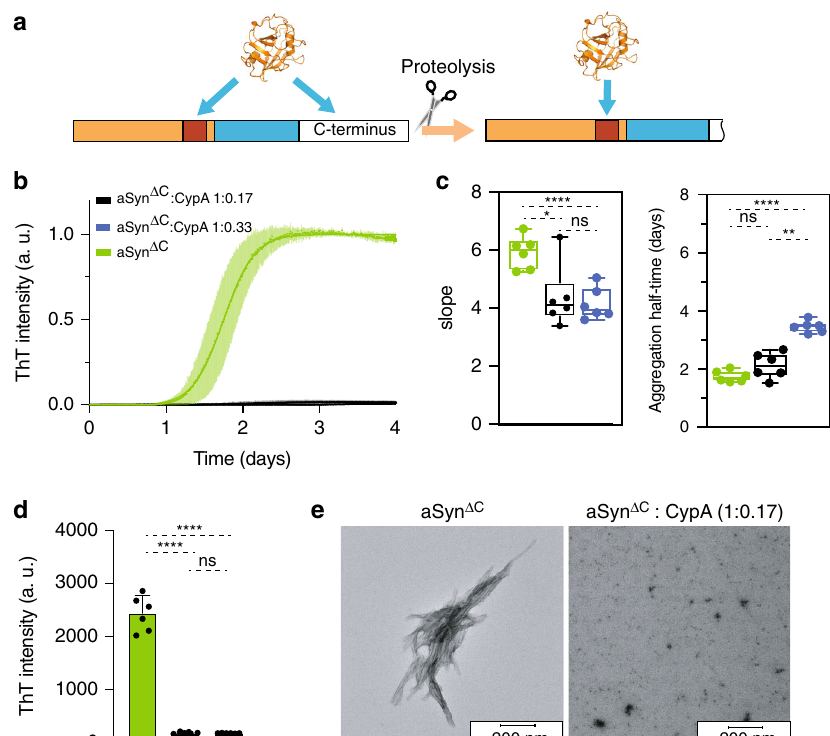
Fig. 5 CypA blocks misfolding of C-terminally truncated aSyn. a Schematic representation of post-translational truncation of the C-terminal domain of aSyn. Truncation leads to a partial or full loss of the proline-rich region and exclusive binding of CypA to aSyn ’ s PreNAC. b ThT- fi brillization assay of C- terminally truncated aSyn alone (aSyn Δ C , 15 μ M, green) and in the presence of substoichiometric concentrations of CypA. Error bars represent the standard deviation of n = 6 independent experiments. An independent experiment leading to the same results, can be found in Supplementary Fig. 8. c Aggregation kinetics of aSyn Δ C in the absence (green) or presence of CypA (derived from ThT data in ( b )). Box plots represent the median (middle line), 25th, and 75th percentile (box), while the whiskers span from the minimum to the maximum value. Note that the maximum ThT intensity is strongly decreased in the presence of CypA (see ( d )). d Absolute values of ThT intensity after 4 days of aggregation of aSyn Δ C in the absence (green) or presence of CypA. Data from aSyn Δ C :CypA molar ratios of 6:1 and 3:1 are shown in black and blue, respectively. Data points represent the mean values from n = 6 independent experiments ±1 SD. One-way ANOVA analysis: ns = P > 0.05, “ * ” = P ≤ 0.05, “ ** ” = P ≤ 0.01, “ *** ” = P ≤ 0.001, “ **** ” = P ≤ 0.0001. e Representative electron micrographs of aSyn Δ C samples at the end of the aggregation assay shown in ( b ). Ten electron micrographs were